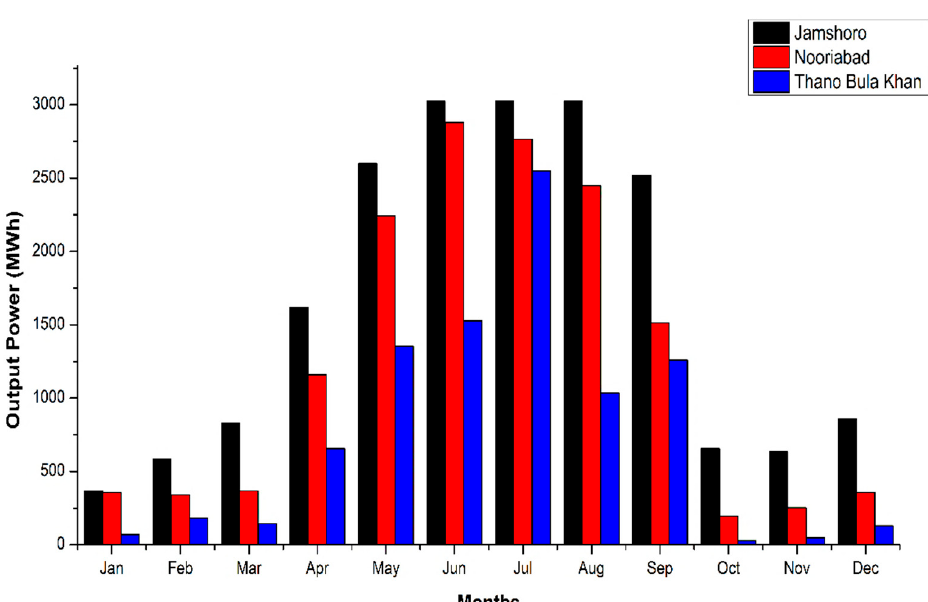
Figure 16 . Power output in MWh for Zone 4 (Jamshoro).